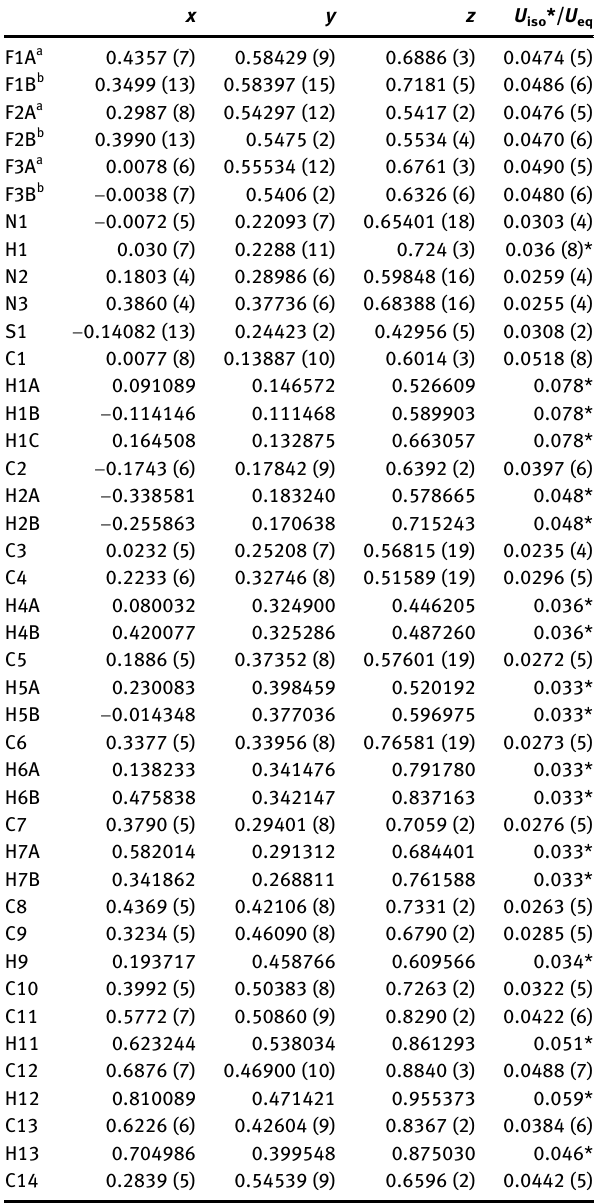
Table  : Fractional atomic coordinates and isotropic or equivalent isotropic displacement parameters (Å 